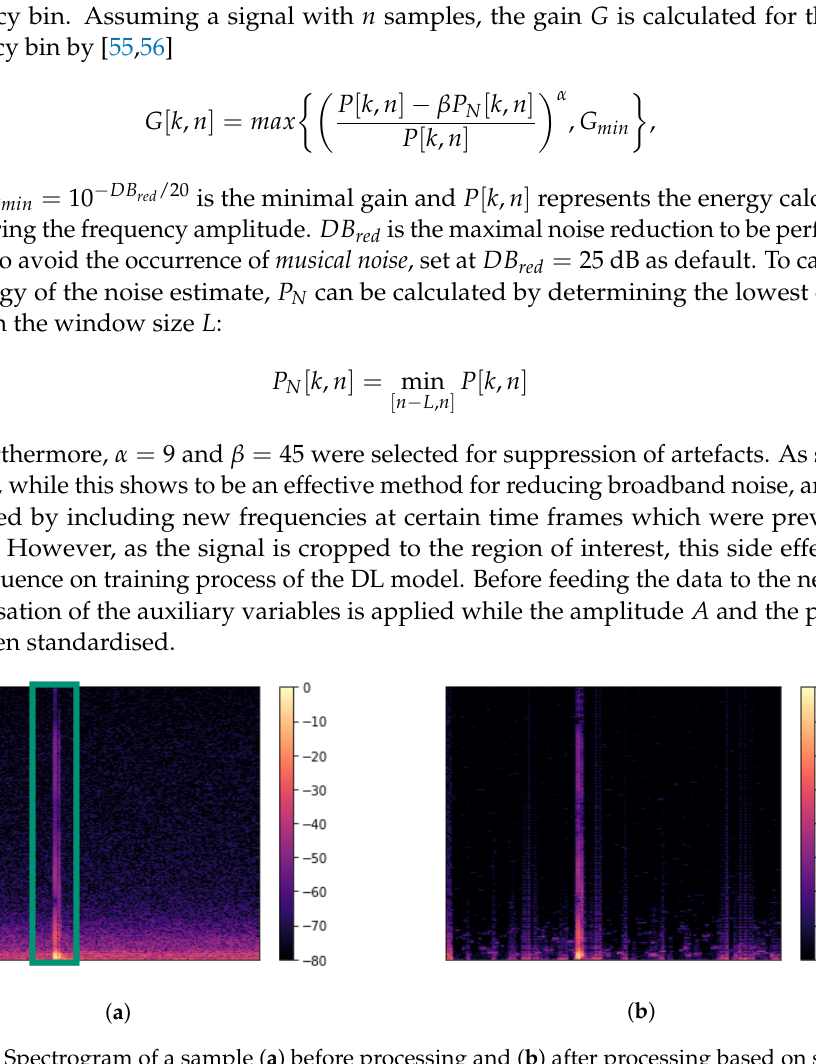
Figure 1. Spectrogram of a sample ( a ) before processing and ( b ) after processing based on spectral subtraction by using a SCNR algorithm with parameters β = 45 and α = 9. As shown in panel ( b ), a reduction of the low frequency noise is achieved without degrading the signal of interest. A side effect is the generation of artefacts by masking new frequencies at different time periods. As the signal of interest is of short period, the artefacts have little impact. The green box in panel ( a ) resembles the crop towards the signal of interest.